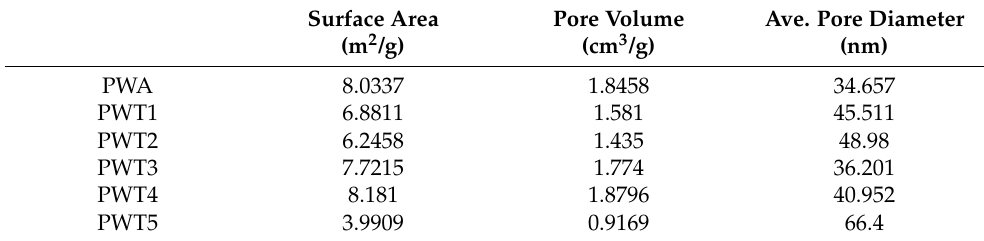
Figure 4. ( a ) Thermogravimetric variations exhibited by the PWTx composites and pristine PWA un- der air. ( b ) Nitrogen gas adsorption–desorption isotherms of the PWA and the synthesized catalysts. Table 2. Physical properties of PWA and the synthesized catalysts.